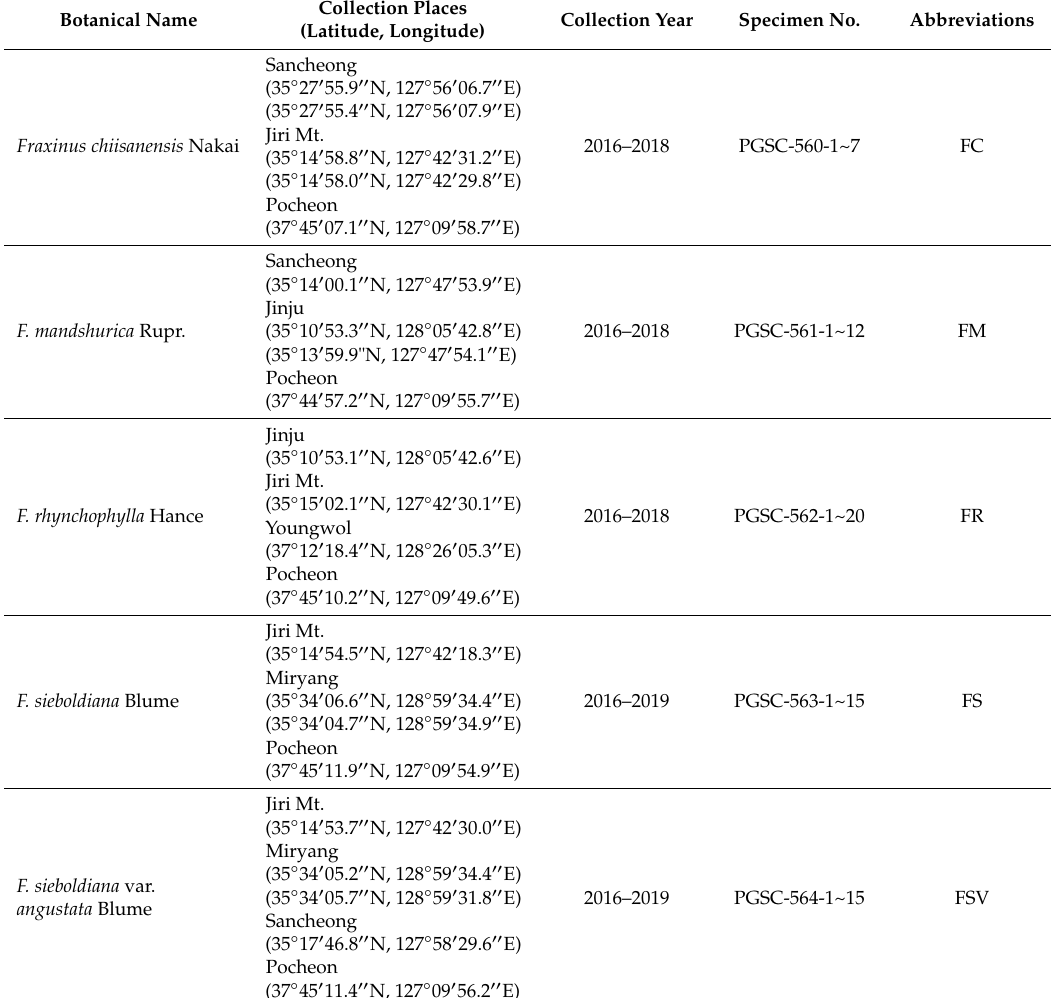
Table 6. A list of Fraxinus plants collected from